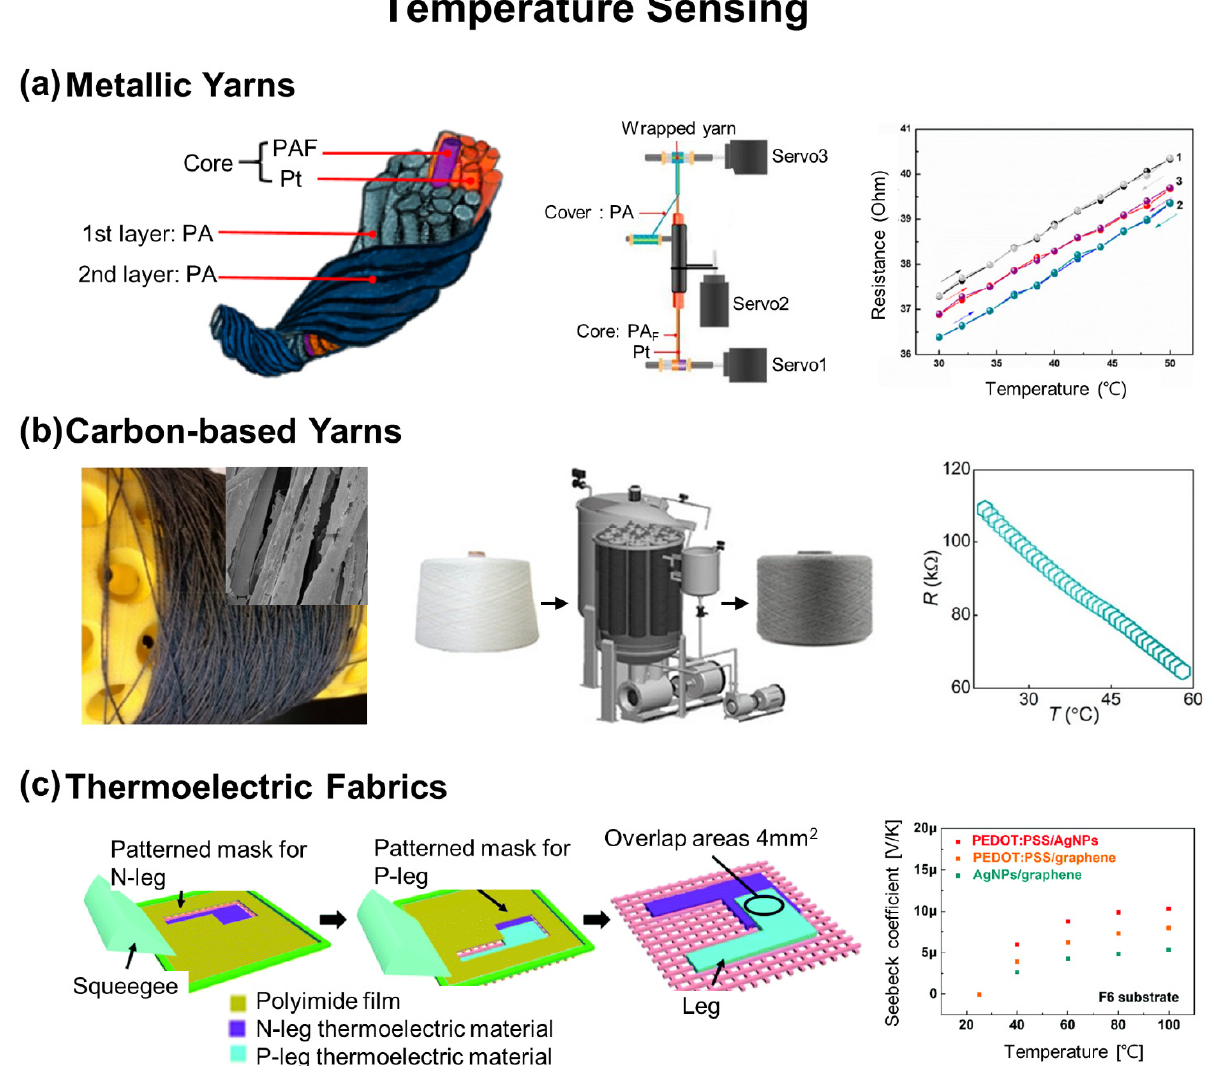
Figure 2. E-textiles for temperature sensing. ( a ) Metallic yarn-based sensing. Reprinted with permission from [70]. Copyright 2019 MDPI. ( b ) Carbon-based yarn-based sensing. Reprinted with permission from [72]. Copyright 2019 American Chemical Society. ( c ) Thermoelectric fabric-based sensing. Reprinted with permission from [48]. Copyright 2018 Royal Society of Chemistry.